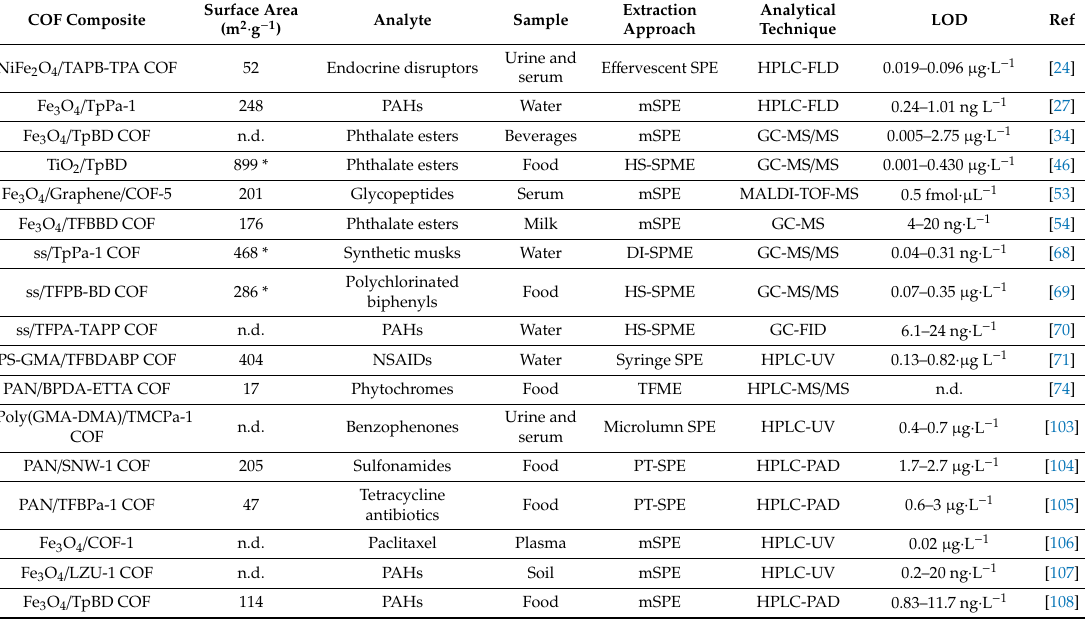
Table 3. Applications of COF composites in extraction and microextraction strategies for sample